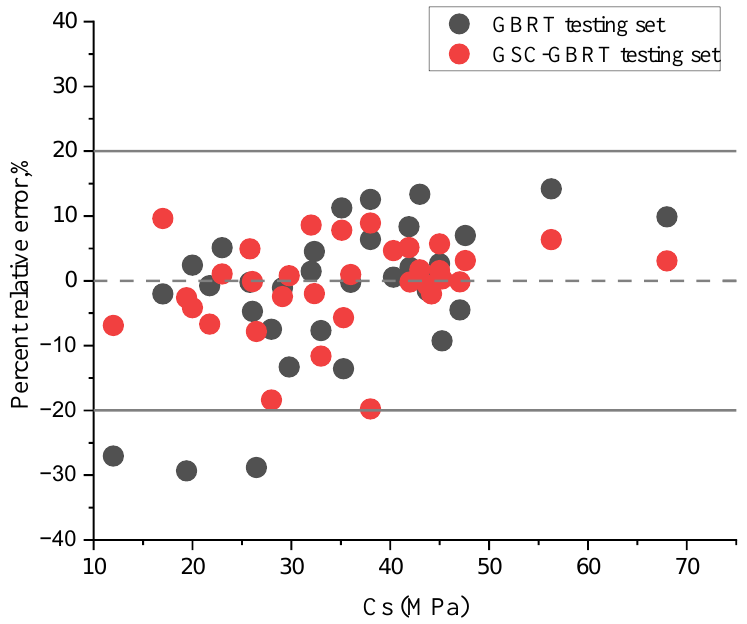
Figure 6. Error distribution for the developed models.